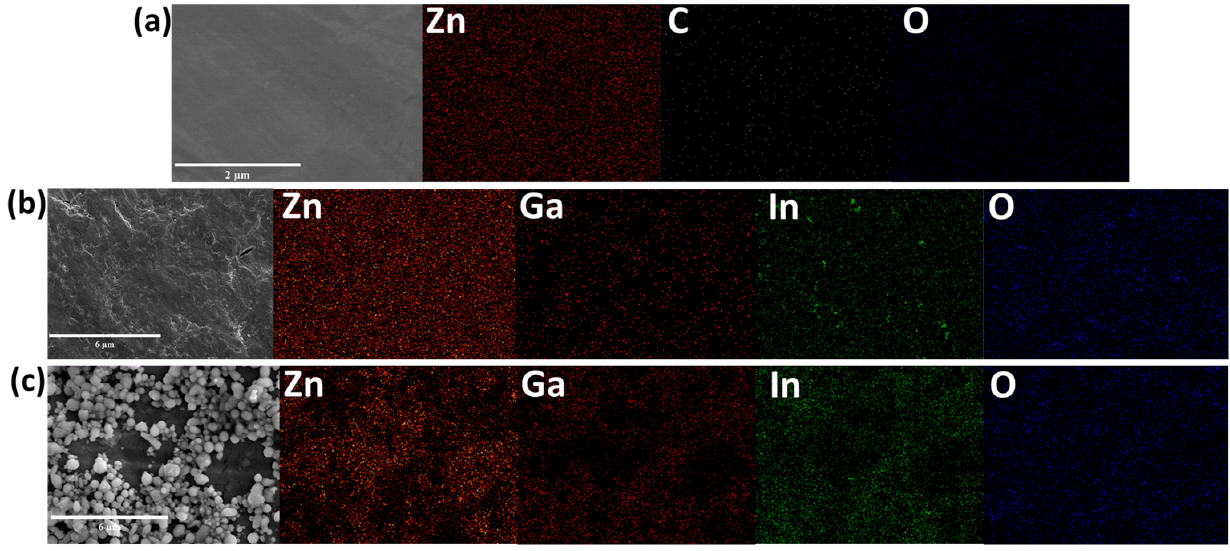
Figure 2. SEM/EDS elemental mapping images of ( a ) bare Zn anode, ( b ) Zn@BLM, and ( c ) Zn@LMNP